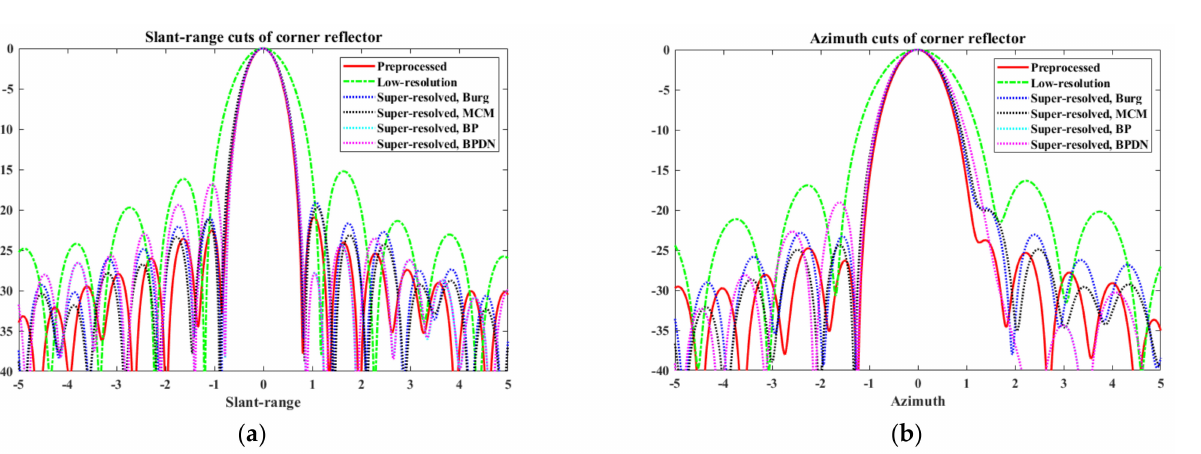
Figure 6. Slant-range cuts and azimuth cuts of PR, LR, and super-resolved target images: ( a ) slant- range cuts, ( b ) azimuth